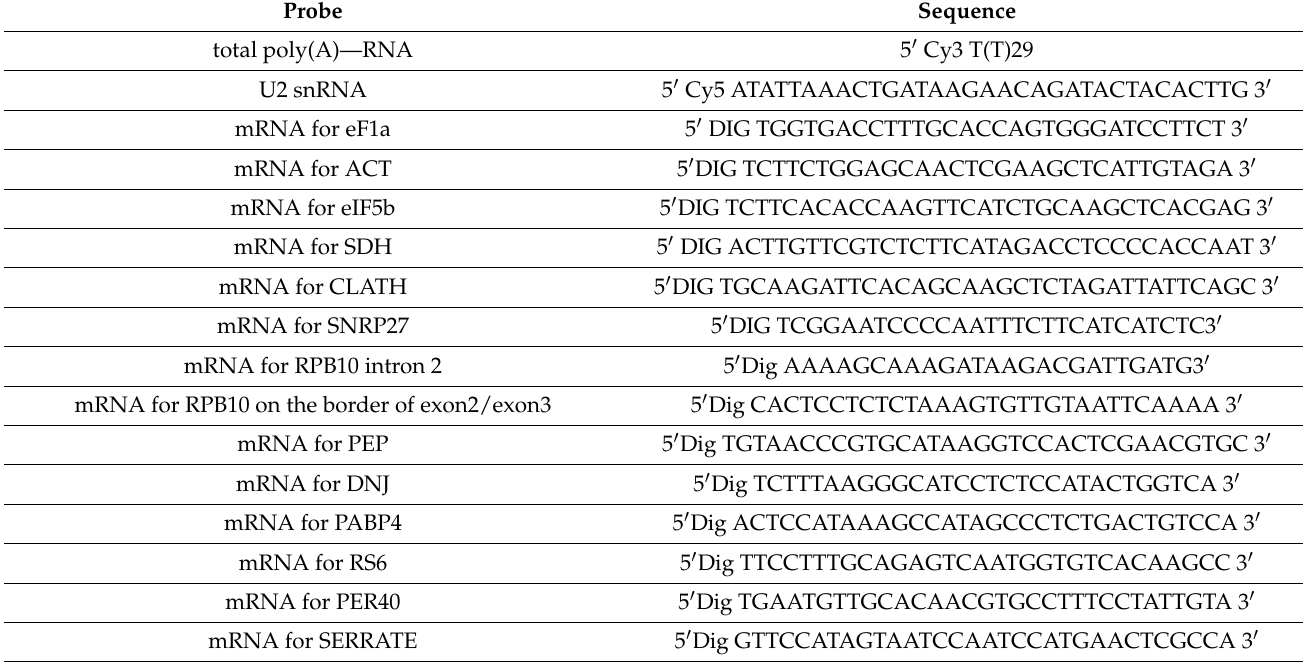
Table 1. The sequences of the used probes for the FISH